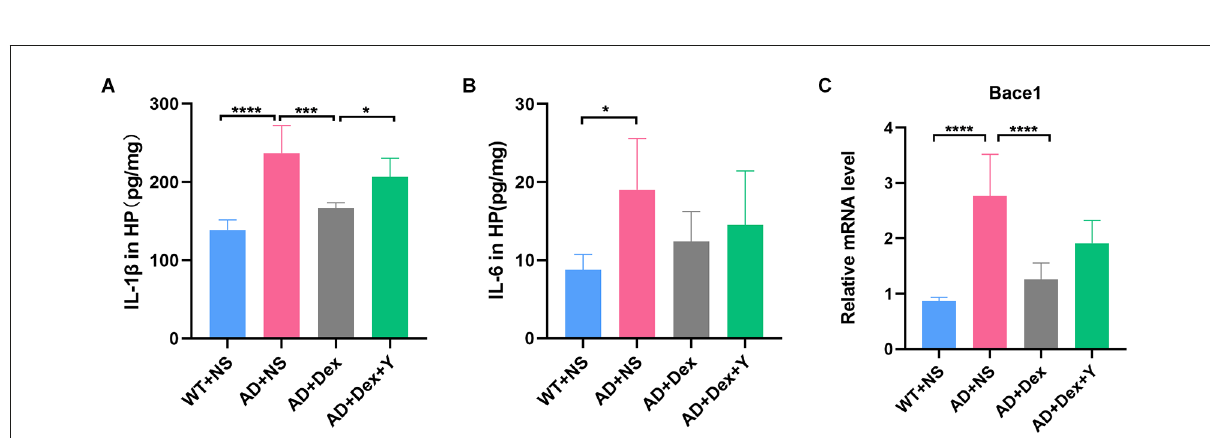
FIGURE3 Panels (A,B) show ELISA data of IL-1 β and IL-6 expression levels in the hippocampus ( n = 6 in each group). (C) The expression level of Bace1 in qRT-PCR ( n = 6 in each group). * p < 0.05, *** p < 0.001, **** p < 0.0001.